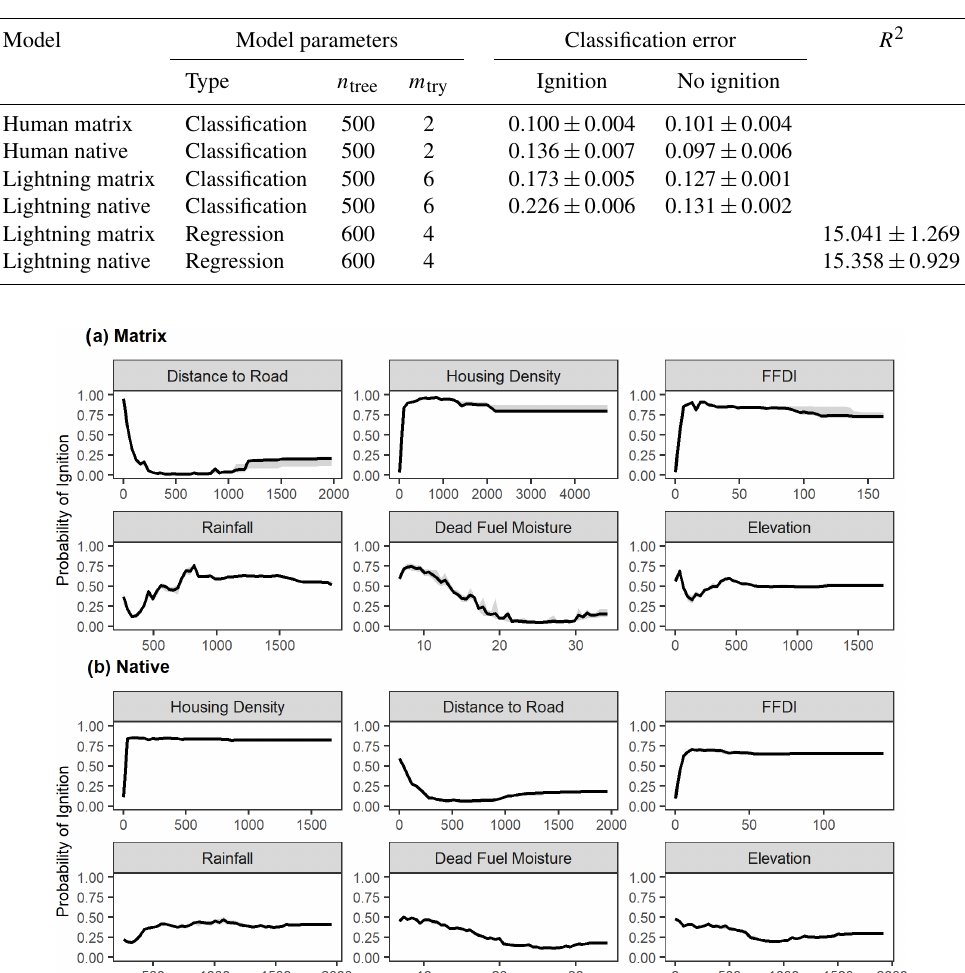
Table 2. Random forest results for human ignitions and GPATS lightning data. Model parameters indicate where the random forest was a classification or a regression, how many trees were built ( n tree ) and the number of variables tested at each split ( m try ). Average and standard deviation from the 10-fold cross-validation of classification error for points classed as ignitions compared with points with no ignition are given for classification models. Average and standard deviations from the 10-fold cross-validation are provided for the variance explained ( R 2 ) of regression models.